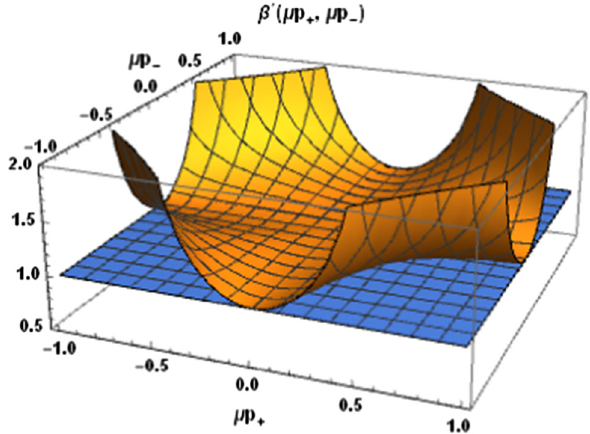
Fig. 10 Anisotropy velocity (123) (when μ α = μ ) as a function of (μ p + ,μ p − ) compared with the standard anisotropy velocity β (cid:11) =